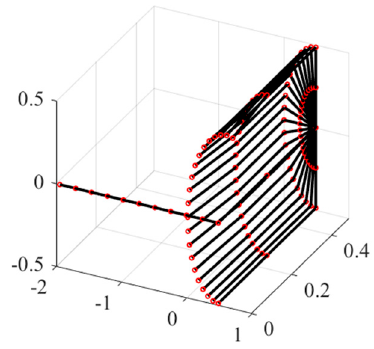
Figure 19. SMSRS reconfigure in linear joint paths in case 2.